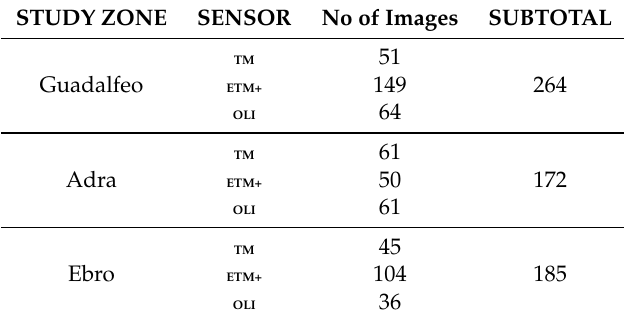
Table 1. Set of images